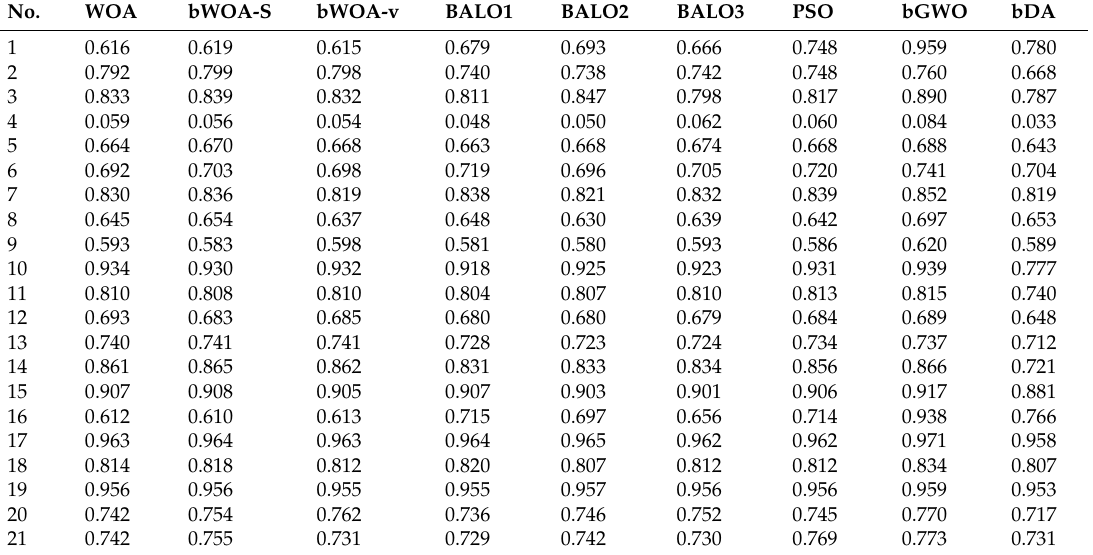
Table 6. Average classification accuracy on the different datasets for the compared algorithms using large